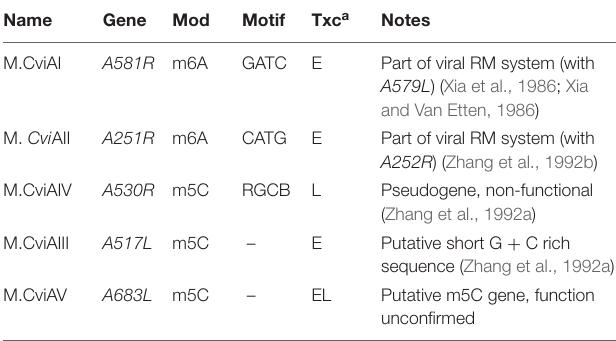
TABLE 1 | Characteristics of DNA methyltransferases encoded by